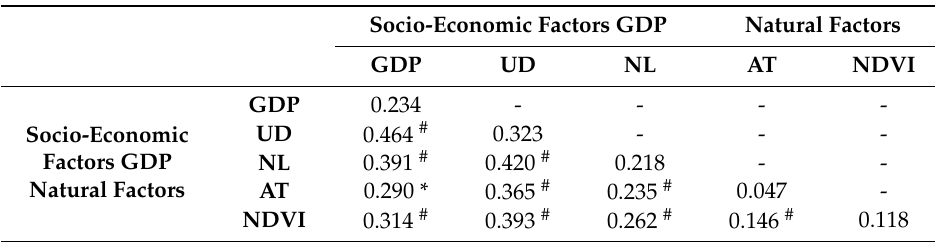
Table 4. The result of interaction